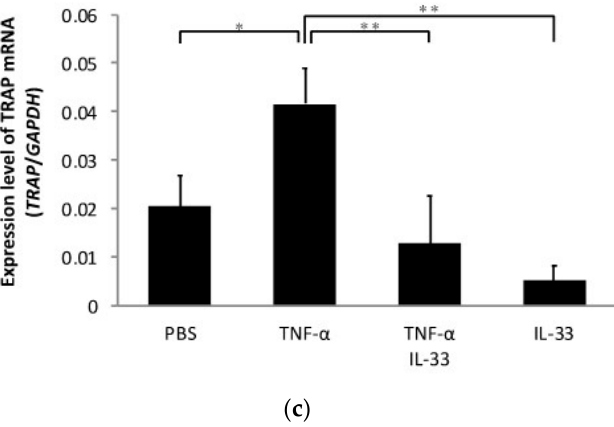
Figure 2. IL-33 inhibited TNF- α -induced osteoclast formation in vivo. ( a ) Microscopic images of histological sections from mouse calvariae after 5 days of daily supracalvarial administration of phosphate-buffered saline (PBS), TNF- α , TNF- α + IL-33, or IL-33. These sections were stained with TRAP solution. Hematoxylin was used as counterstaining. Scale bars = 100 µm. The number of TRAP- positive cells in the suture of calvariae among the four groups. Results are expressed as means ± SD. The statistical significance of differences was determined by Scheffe’s test ( n = 4; * p < 0.05, ** p < 0.01).